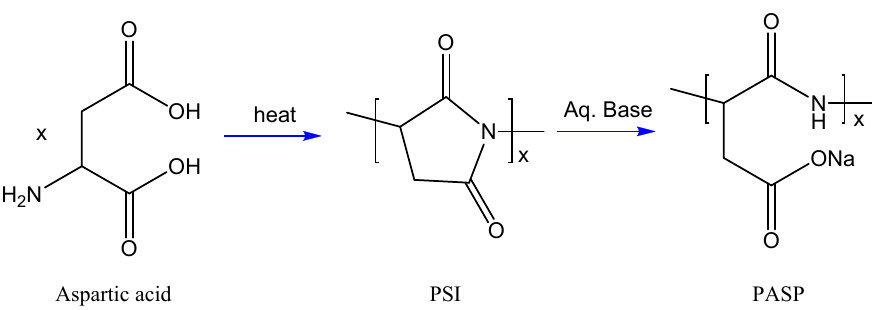
Figure 4. Typical synthetic route of poly (aspartic acid) (PASP) from aspartic acid.